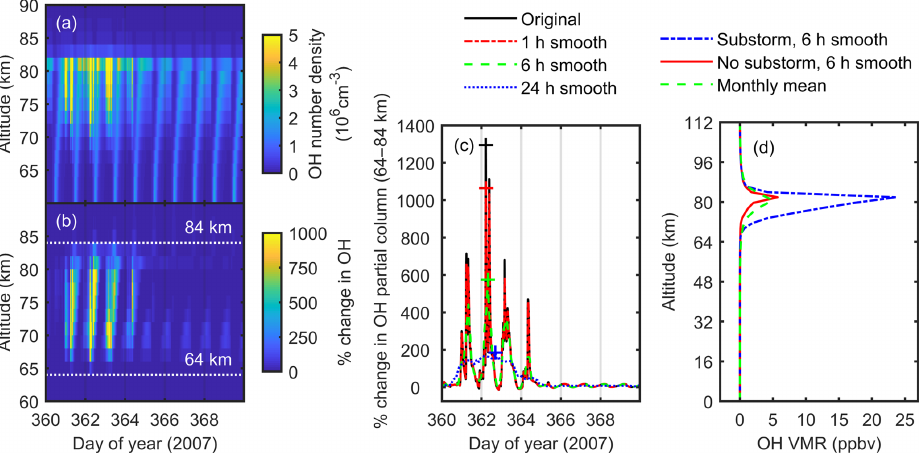
Figure 3. Derivation of hydroxyl radical (OH) volume mixing ratio profiles from atmospheric model datasets. Panel (a) shows OH number densities calculated by the SIC model for December 2007 substorm conditions at Kilpisjärvi (69 ◦ 03 (cid:48) N, 20 ◦ 48 (cid:48) E), Finland. Panel (b) shows the percentage change in modelled O 3 abundance from background (no substorm) conditions. Panel (c) shows the percentage change in OH partial column over altitudes 64–84km during substorm conditions for the original (15min) model resolution and 1, 6, and 24h smoothed data. “ + ” symbols indicate the largest increases in OH partial column at each nominal time resolution. Panel (d) shows the 6h smoothed OH VMR profiles for December substorm, background (no substorm), and monthly mean